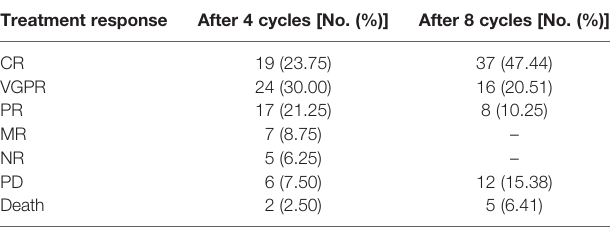
chemotherapy. Treatment response